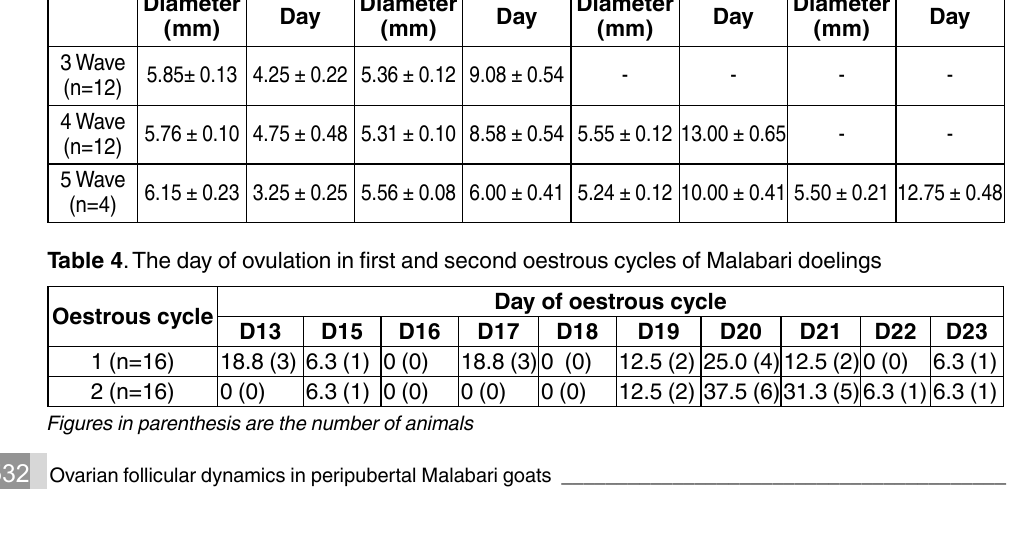
table 3 . Mean diameter (mm) and day of largest follicles inthree, four and five wave cycles Diameter (mm) and day of largest follicles Wave 1 Wave 2 Waves